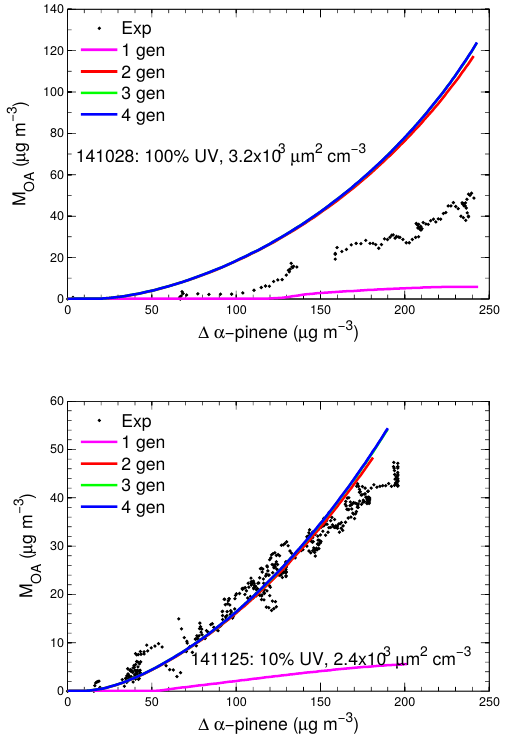
Figure 4. Mass of SOA as a function of reacted α -pinene. Experi- mental data are shown with filled circles. Solid lines correspond to GECKO-A predictions from different generations of reaction using a vapor wall loss rate k gw = 10 − 5 s − 1 , where a generation corre- sponds to reaction with an oxidation such as OH up to formation of a stable product.